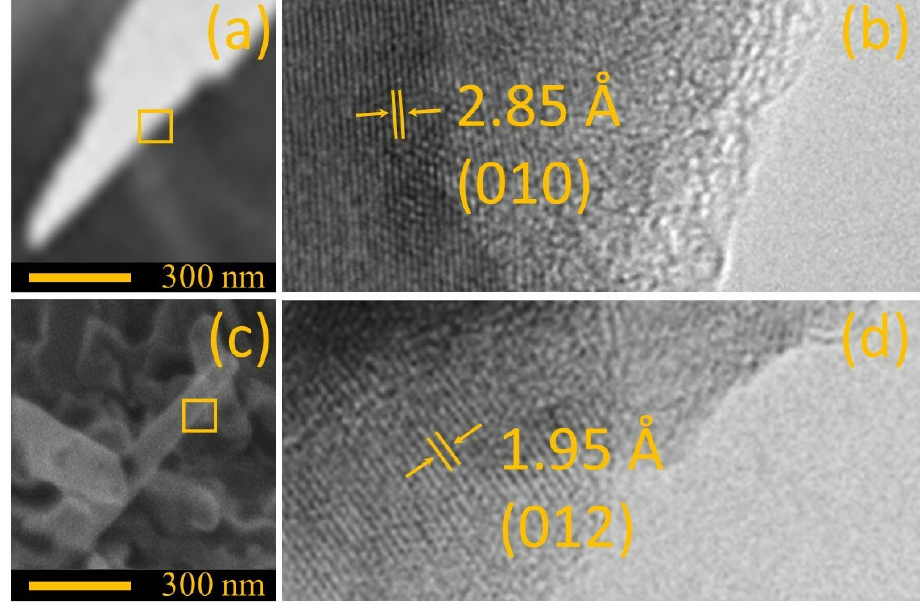
Figure 3. Comparison between ( a ) a single ZnO grass-like nanostructure and ( b ) ZnO cane-like nanostructure imaged by SEM. ( c , d ) Close view of the interface imaged by HRTEM of samples ( a , b ), respectively.